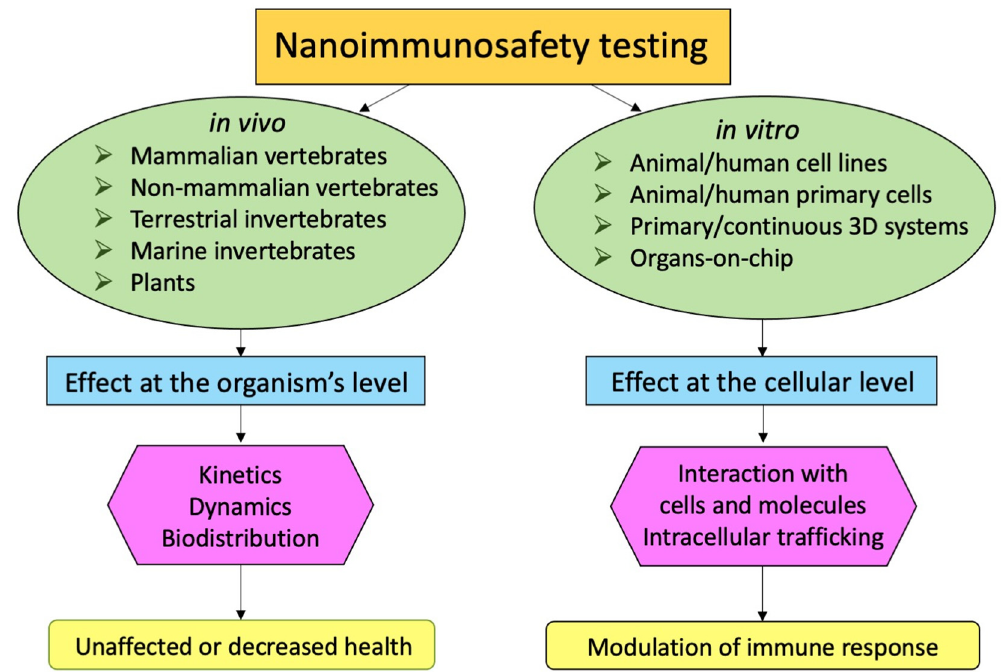
Figure 2. In vivo and in vitro models for nanoimmunosafety testing. The in vivo models used for immunosafety testing can provide useful information at the organism’s level, including biodistribution and elimination kinetics and possible pathological consequences. The in vitro models can unravel the cellular, subcellular and molecular mechanisms underlying the nano-immune interactions.